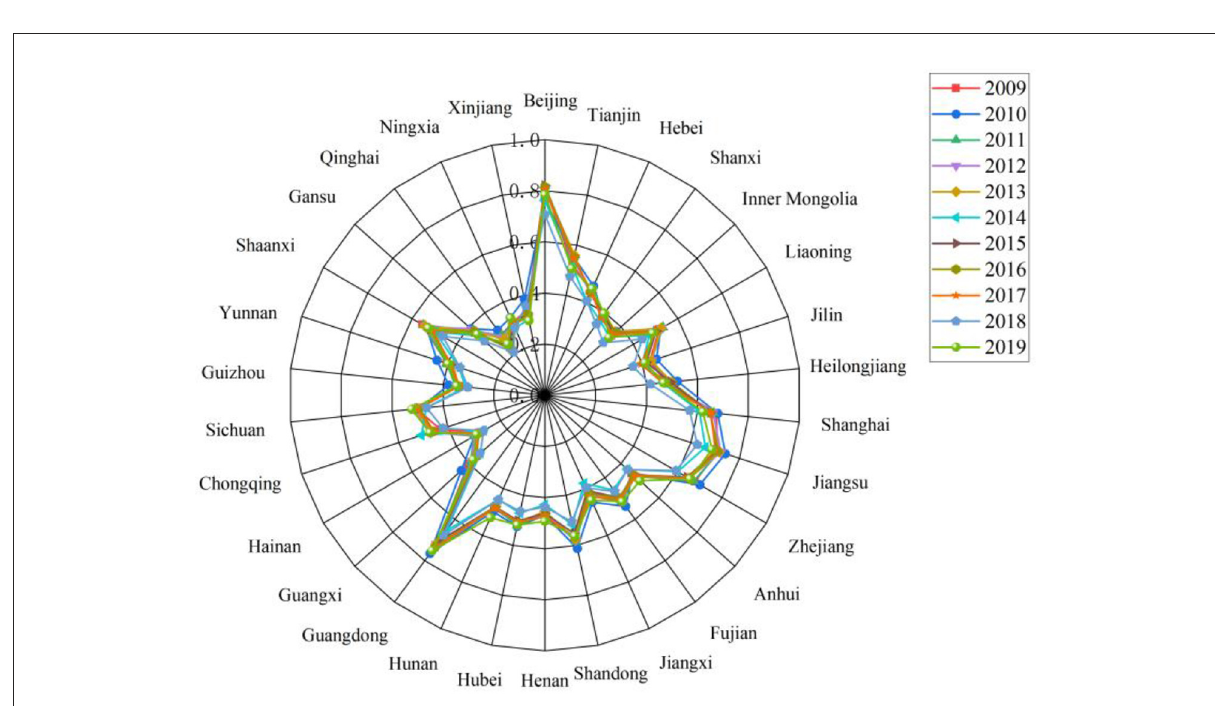
FIGURE5 Coupling coordination degree of “LCD-TI-NU” system in China’s provinces and cities,